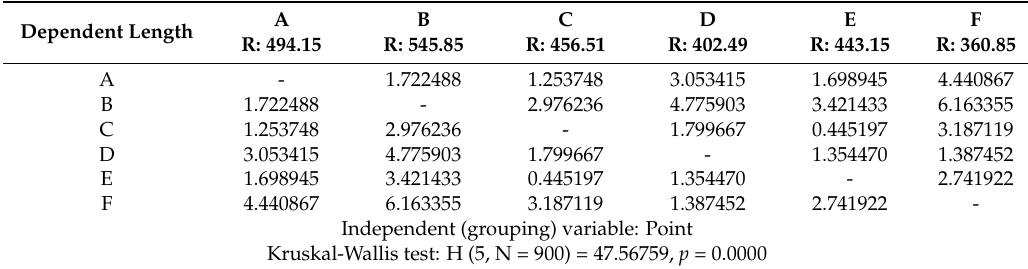
Table 8. Multiple comparisons z ’-values of length values for point variable.